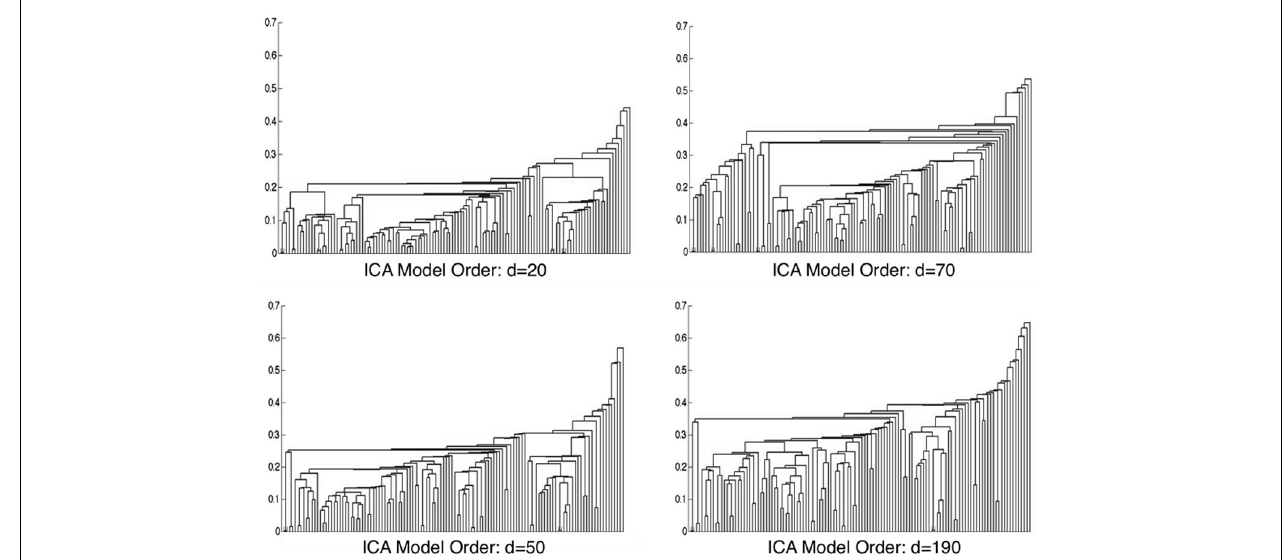
FIGURE 4 | Hierarchical clustering dendrograms are shown for ICA model orders of 20, 50, 70, and 190. Model orders of 20 and 70 resulted in the two highest CC c values, while d = 50 and d = 190 resulted in the lowest CC c values. The dissimilarity scale (y-axis) of each dendrogram indicates how strongly the behaviors and paradigms